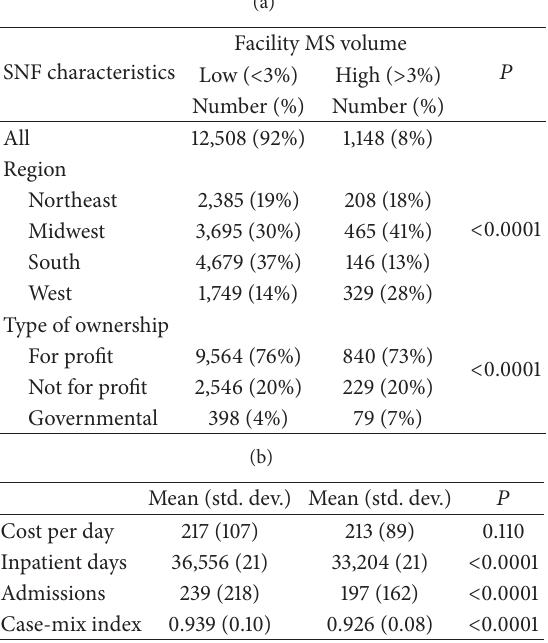
Table 1: Characteristics of SNF facilities with high versus low MS